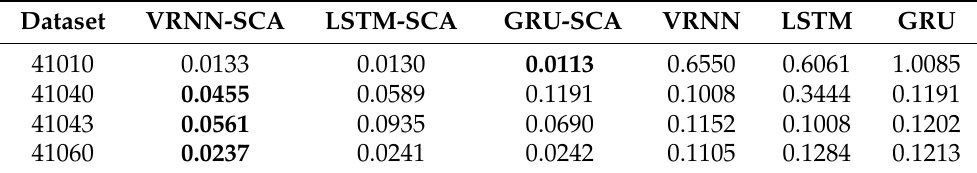
Table 13. Comparison in terms of average mean absolute error (MAE) on all dataset.